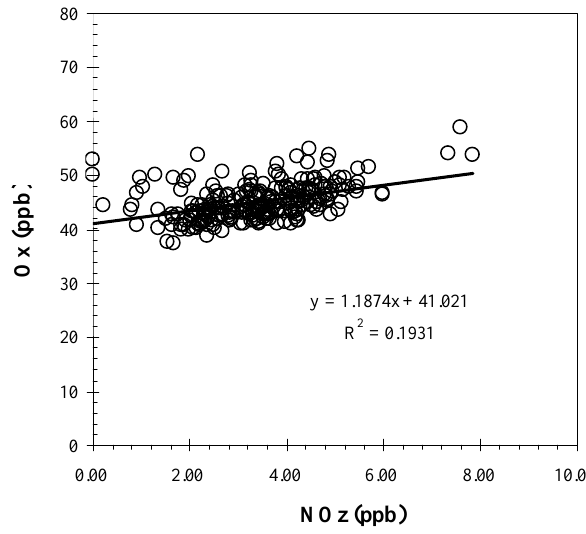
Fig. 8. Correlation between O x and NO z observed at the PKU ob- servatory during the midday (10:00–14:00) of 15 August 2008. An averaged OPEx of 1.2 molemole − 1 is derived from the linear re- gression